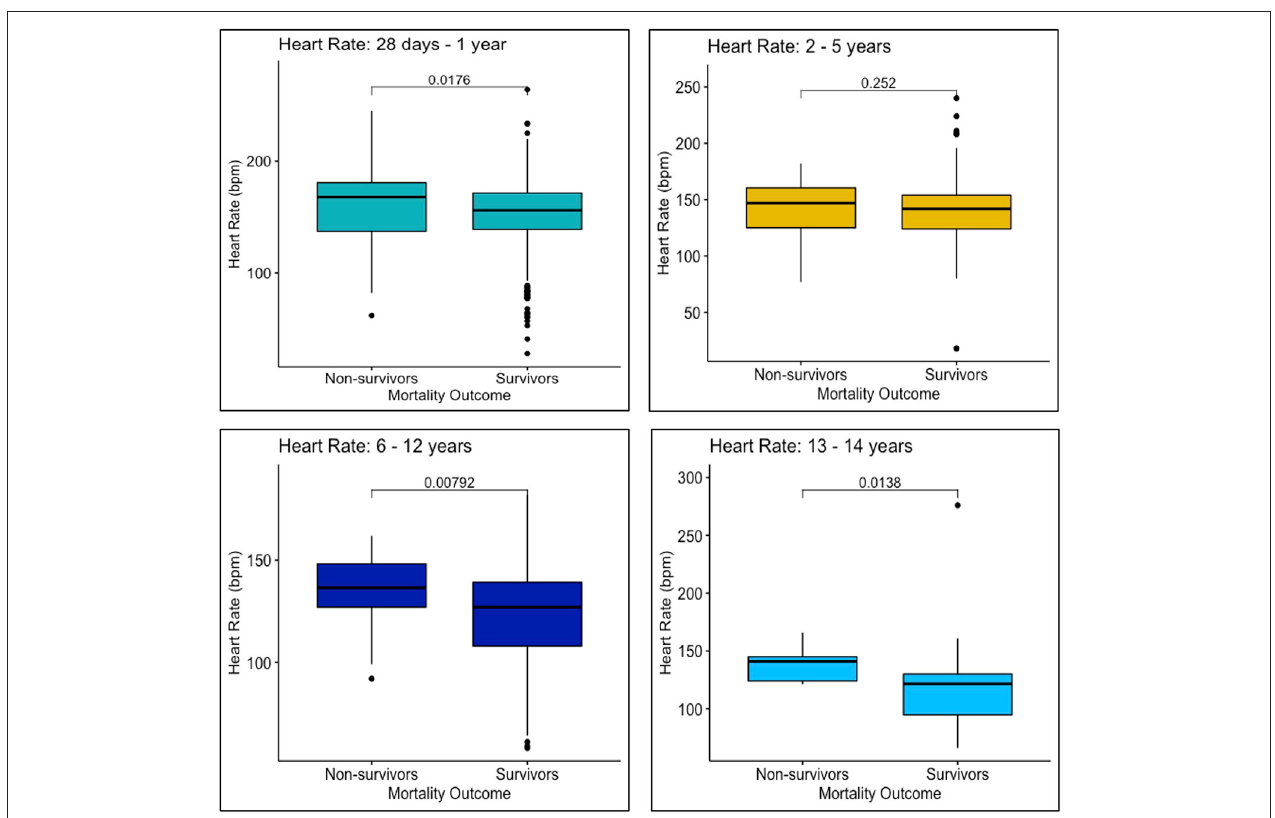
FIGURE 5 | Heart rates upon arrival to MNH of survivors and non-survivors in each age group: 28 days − 1 year, 2–5 years, 6–12 years, and 13–14